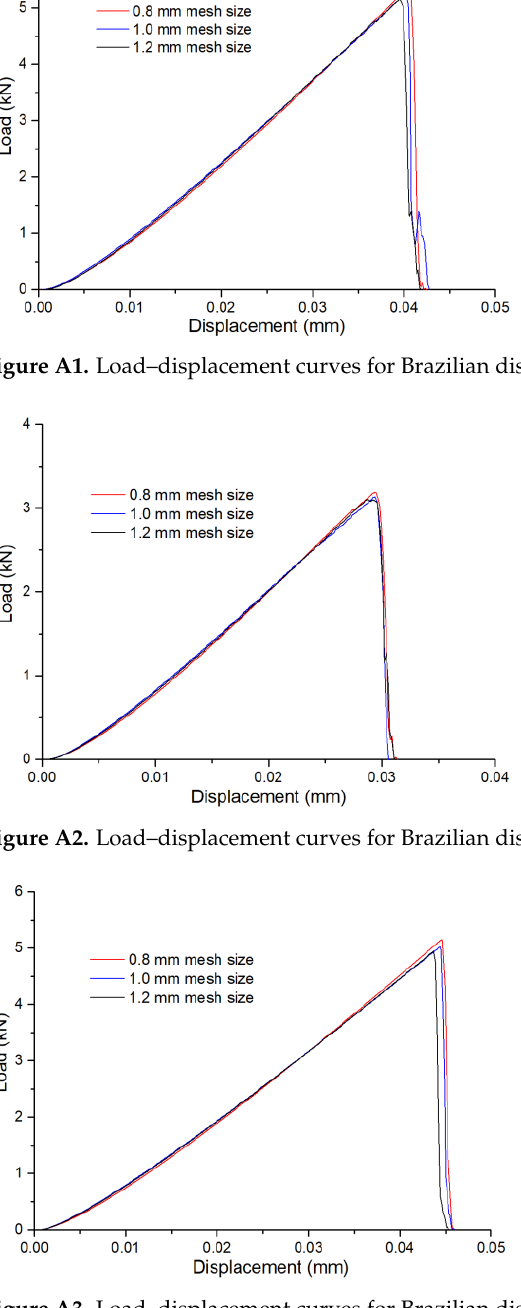
◦ cracks with different mesh Figure A3. Load – displacement curves for Brazilian discs with 90° cracks with different mesh sizes. Figure A3. Load–displacement curves for Brazilian discs with 90 Figure A3. Load – displacement curves for Brazilian discs with 90° cracks with different mesh sizes. Figure A3. Load – displacement curves for Brazilian discs with 90° cracks with different mesh sizes.